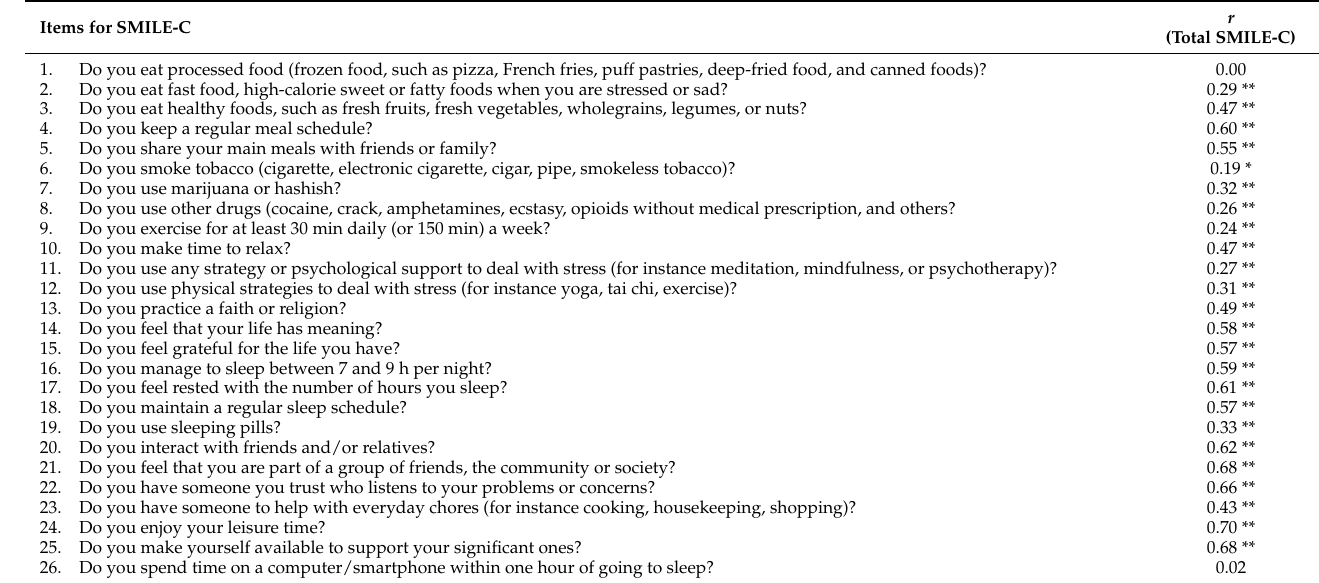
Table 2. Item-total correlation between items of SMILE-C and full score of the